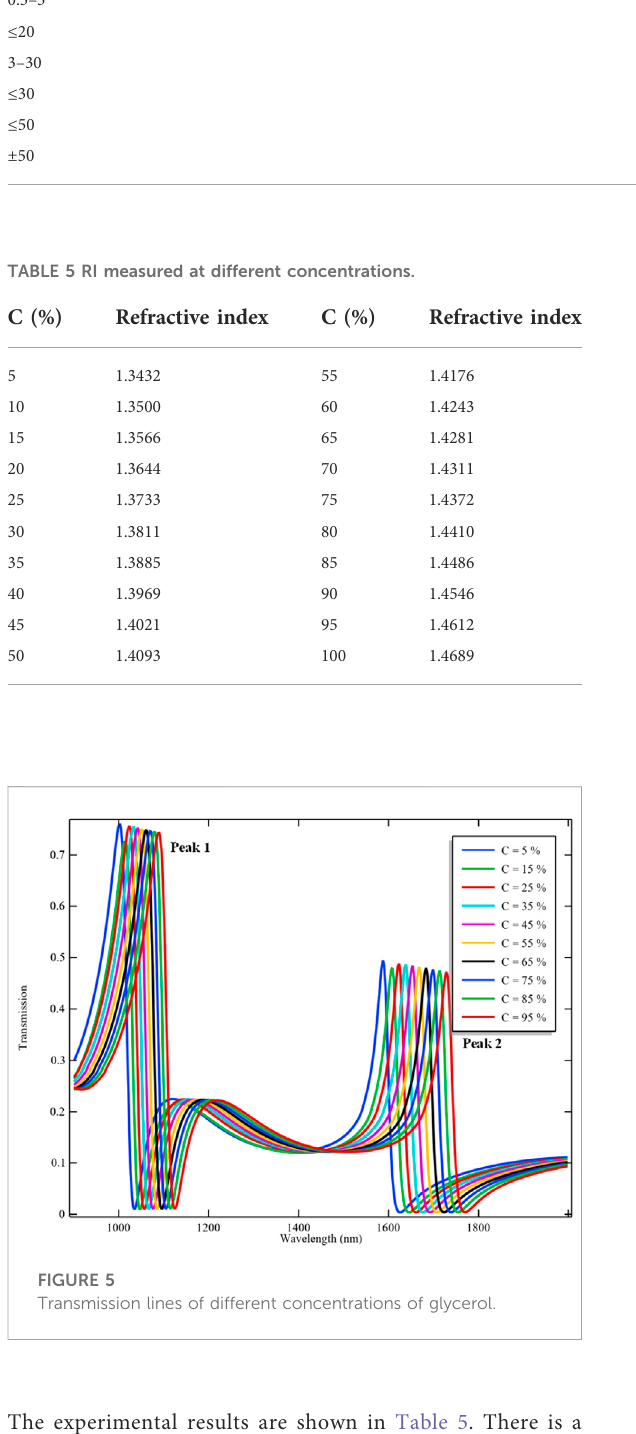
The experimental results are shown in Table 5. There is a linear relationship between concentration and RI as shown in Figure 4. The linear fi tting shows that n = 0.01297C + 1.3408 (n is the RI, and c is the concentration) Table 6 shows the